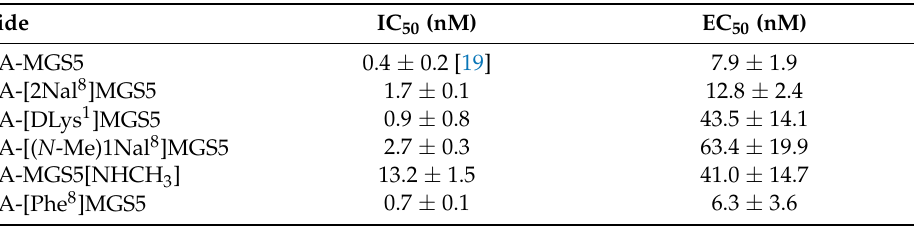
Table 2. IC 50 and EC 50 values of the peptide analogs calculated from competitive binding assays and calcium mobilization assays on A431-CCK2R cells in comparison with previously studied DOTA-MGS5.